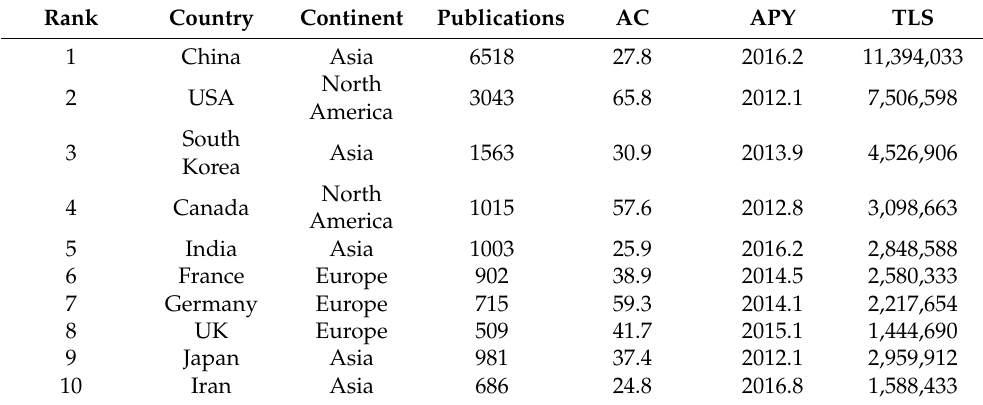
Table 4. Information on the top 10 prolific countries in the field of